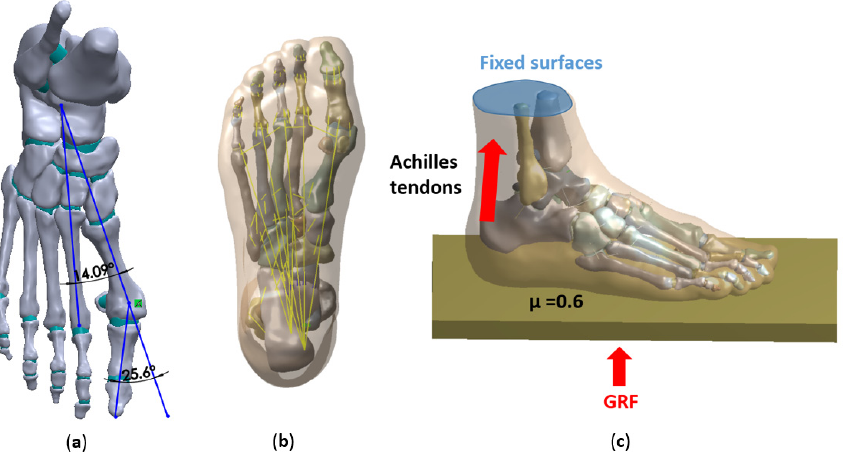
Figure 2. ( a ) HIA and IMA in patients with moderate HV; ( b ) Plantar fascia and ligaments; ( c ) ary conditions and Boundary conditions and load.